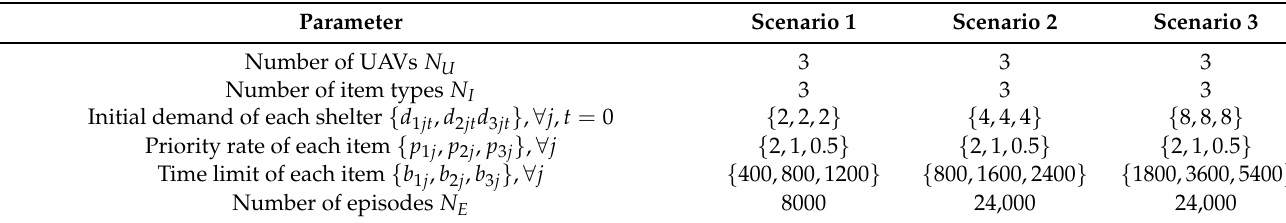
Table 2. The set parameters of each